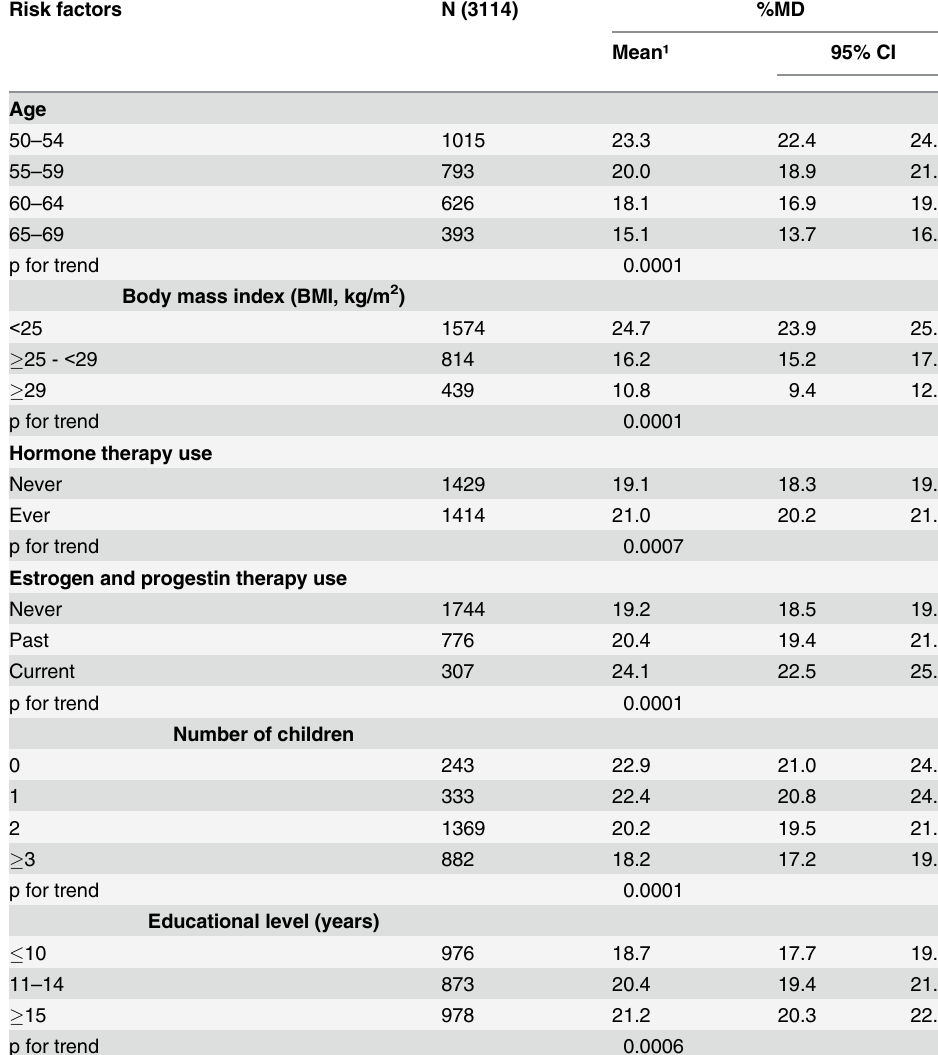
Table 1. Percent mammographic density (%MD) by known breast cancer risk